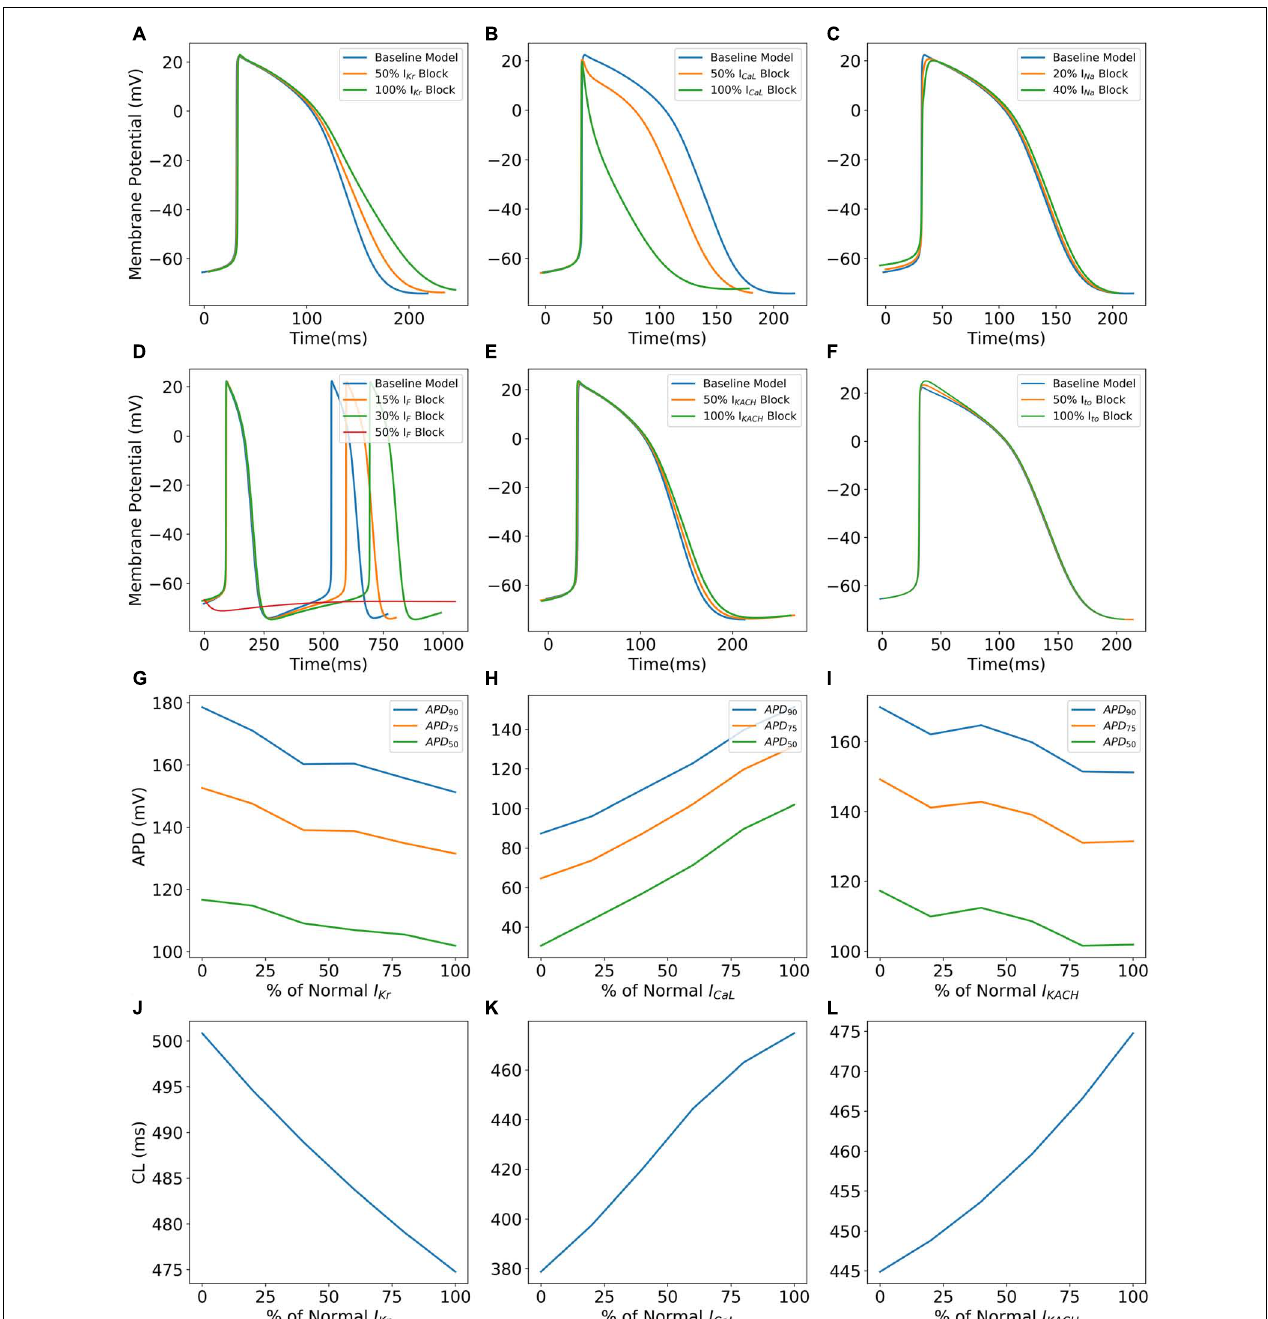
FIGURE 10 | Effect of blocking various ionic currents on AP characteristics in the hiPSC-CM model such as AP morphology (A–F) , AP durations (G–I) , and cycle lengths (J–L) .